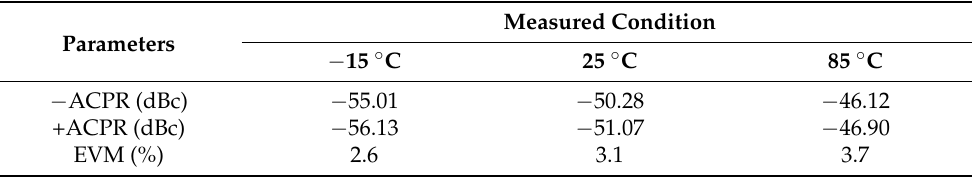
Table 2. Comparison of the measured ACPR and EVM results over temperature.